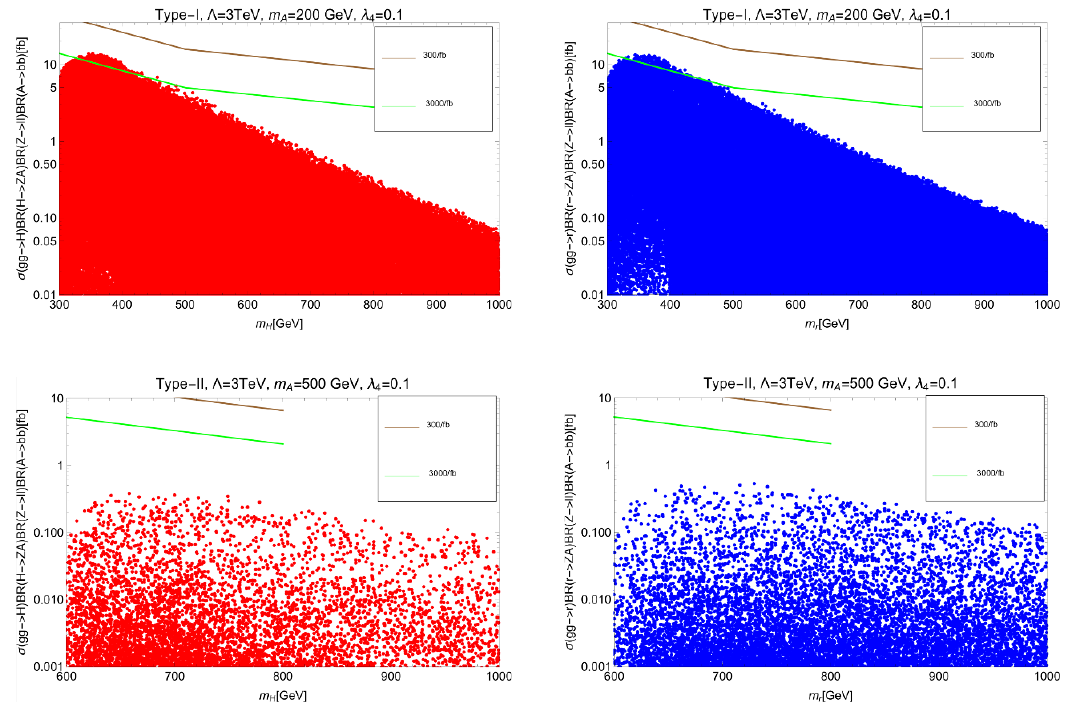
Figure 11 . The observable (cid:27) ( gg ! X ! ZA ) BR ( Z ! l + l (cid:0) ) BR ( A ! b (cid:22) b ) as a function of the resonance mass with X = H (red), r (blue) in the type-I (top) and type-II (bottom) models. We (cid:12)xed (cid:3) = 3TeV, m A = 200GeV( m A = 500GeV) on top (bottom) and (cid:21) 4 = 0 : 1. Due to the custodial symmetry, the charged scalar mass is identical to the pseudoscalar mass, whose value is given above each (cid:12)gure. The heavy neutral Higgs (radion) mass is varied from 200 to 1000 GeV in the right (left) (cid:12)gures and the values of (cid:11) and (cid:12) are chosen to be consistent with the constraints of (cid:12)gure 5. The solid lines represent future upper bounds at the